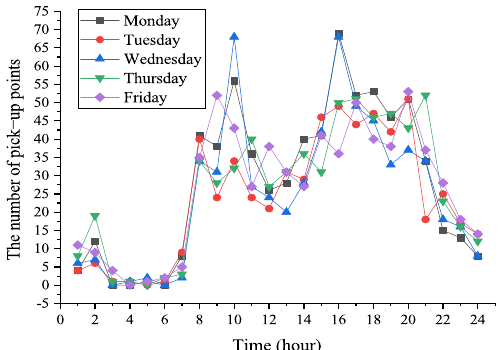
Figure 4. Traffic passenger flows in grid 634 at different times on 5 working